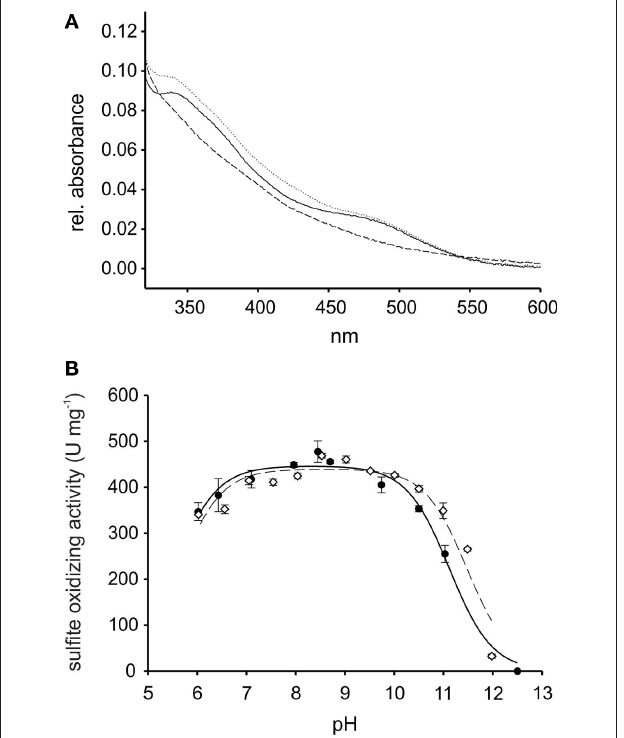
Figure 2 | Properties of recombinant SorT (rSorT) (A) electronic absorption spectra of rSorT (solid line: as prepared, dotted line: oxidized and dashed line: sulfite reduced) (B) comparison of the pH dependency of SorT activity for the native and